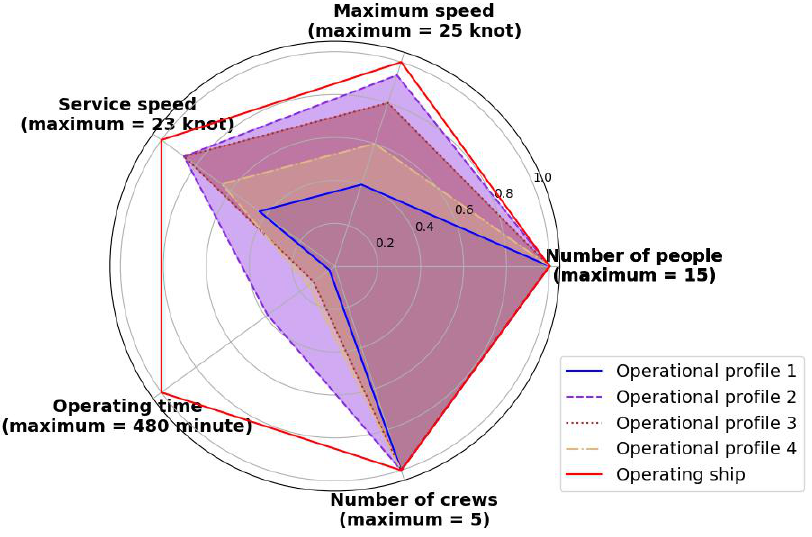
Figure 10. KPIs defined by the operational profiles.